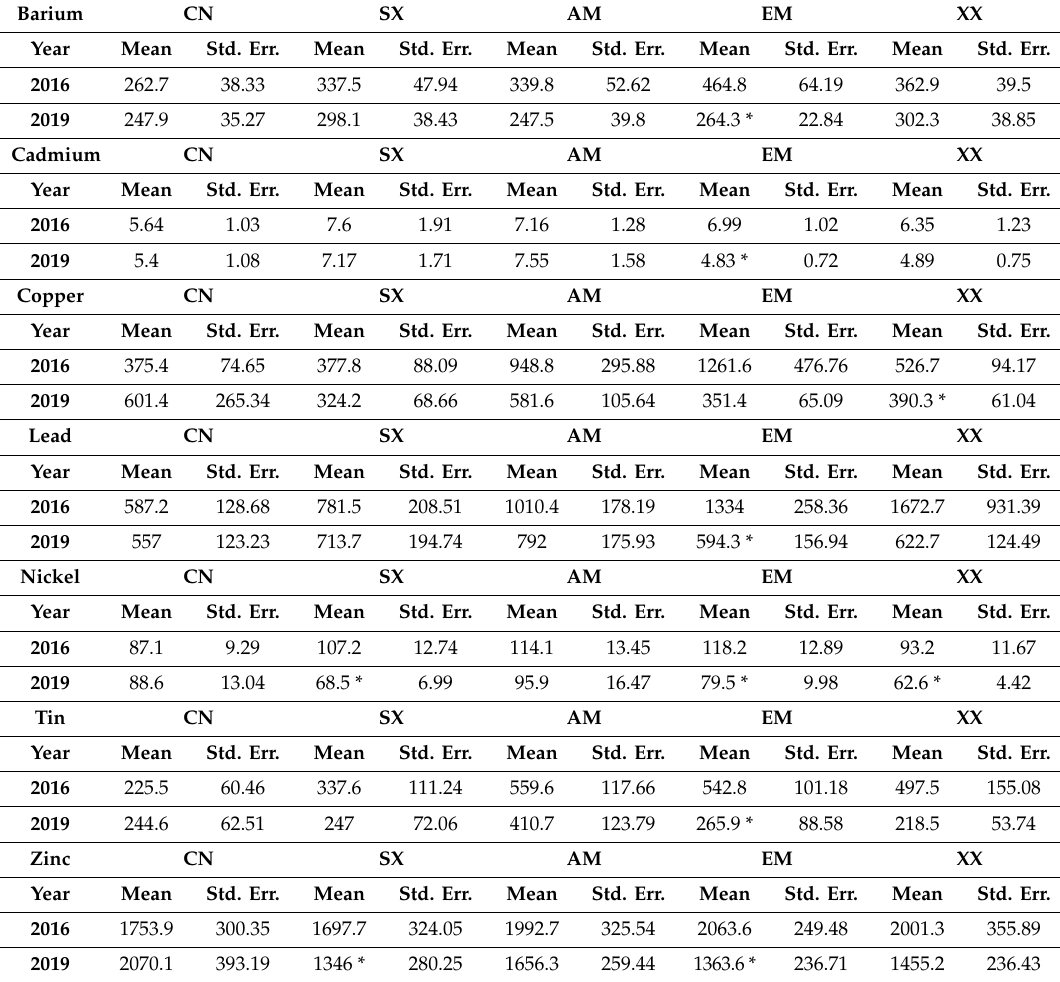
Table 2. Mean TE concentrations and standard error of the soil per treatment as measured in 2016 and 2019 at the Longueuil, QC, industrial landfill